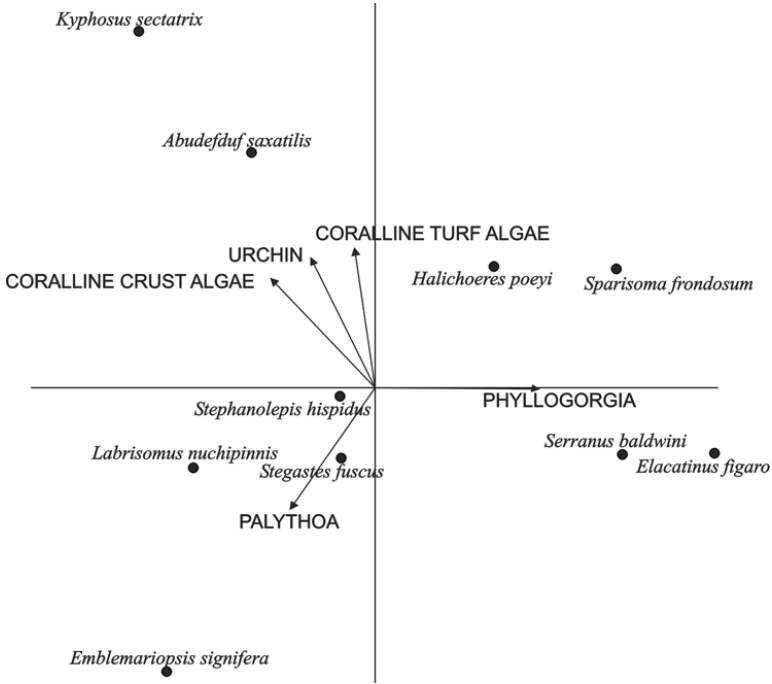
Fig. 7 – Canonical correspondence analysis of fish abundance and benthic organisms obtained from transects on ID patches of Maramutá